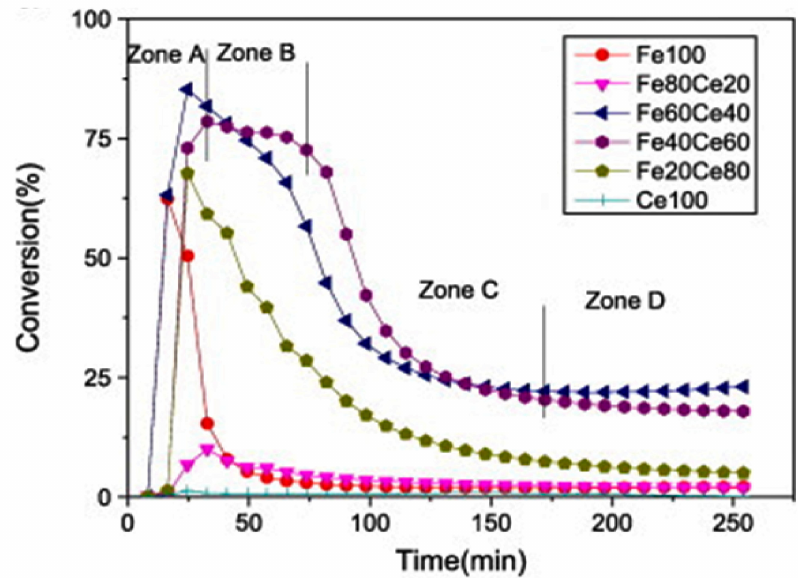
Figure 4. Effects of catalyst composition (different percentages of Fe and Ce) on methane conversion at 750 ◦ C; reprinted with permission from ref. [42]. Copyright 2010 Elsevier.